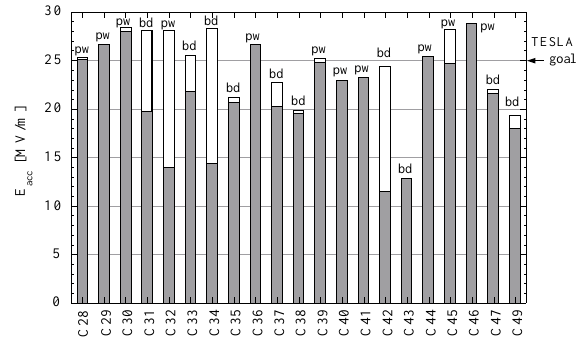
FIG. 21. Test results of the second cavity series (crosshatched bars); plotted is the highest gradient achieved in the first rf test of each cavity at Q 0 $ 5 3 10 9 . Cavities with poor initial per- formance were subjected to an additional BCP and high pressure water rinsing and tested again (open bars). Field limitation by amplifier power (pw) or thermal breakdown (bd) is indicated for the best gradient.